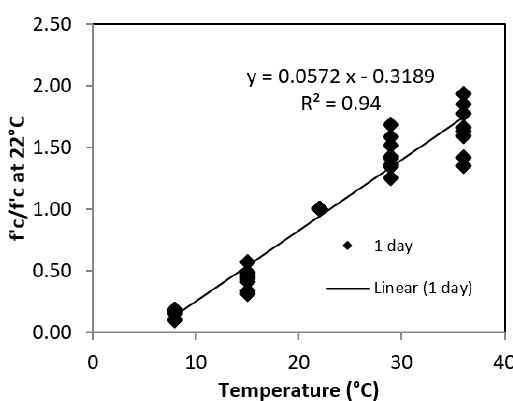
Figure 3. Variations of 1 ‐ day relative compressive strength of CEM mixtures.